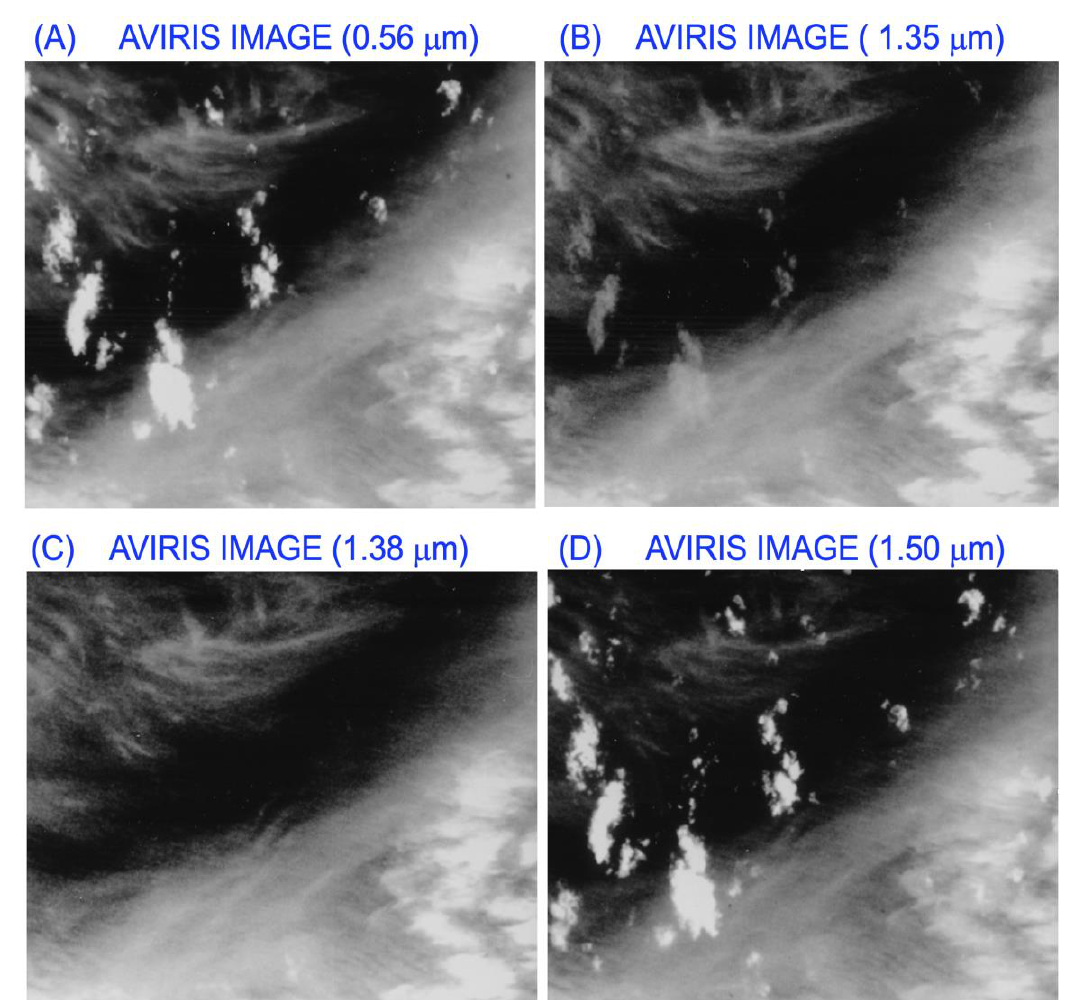
Figure 1. Examples of AVIRIS images for 10 nm wide channels centered at 0.56 ( A ), 1.35 ( B ), 1.38 ( C ), and 1.50 μm ( D ). The images were acquired on 5 December 1991 over the Gulf of Mexico. The image covers an area of approximately 12 by 10 km 2 .